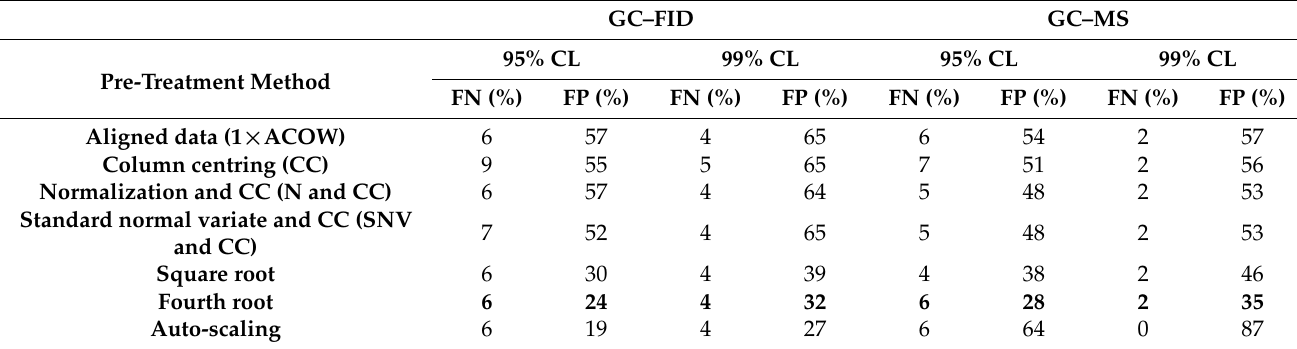
Table 1. An overview of the total FN% and FP% from all studied pre-treatment methods for both GC–FID and GC–MS after aligning once with ACOW. The fourth root normalization, i.e., the best pre-treatment, is marked in bold. GC–FID GC–MS Pre-Treatment